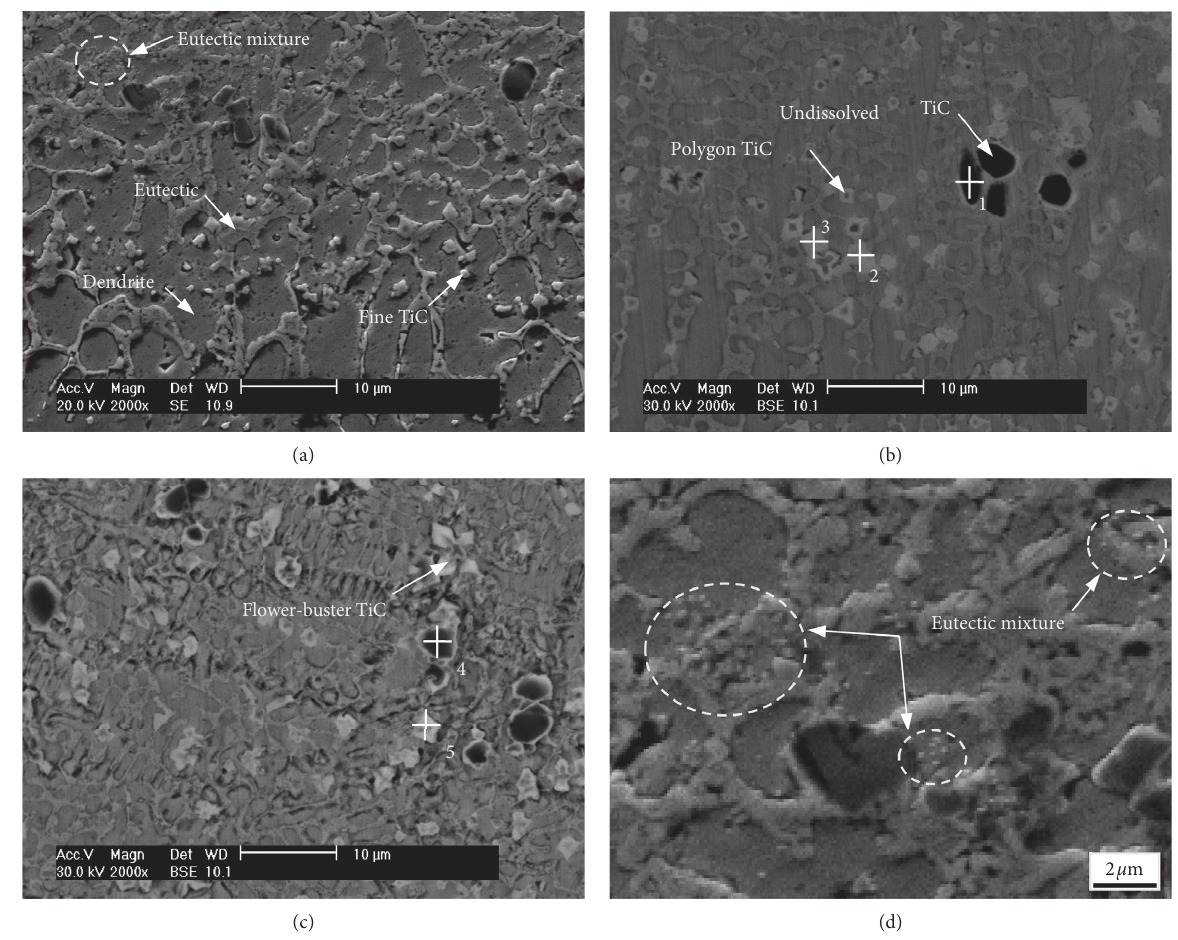
Figure 5: TiC morphologies in different regions of S1 coating. (a) Bottom part. (b) BSE micrograph of middle-part microstructure. (c) BSE micrograph of upper-part microstructure. (d) TiC eutectic mixture (primary TiC: small globe TiC; eutectic mixture TiC; and blocky rosette